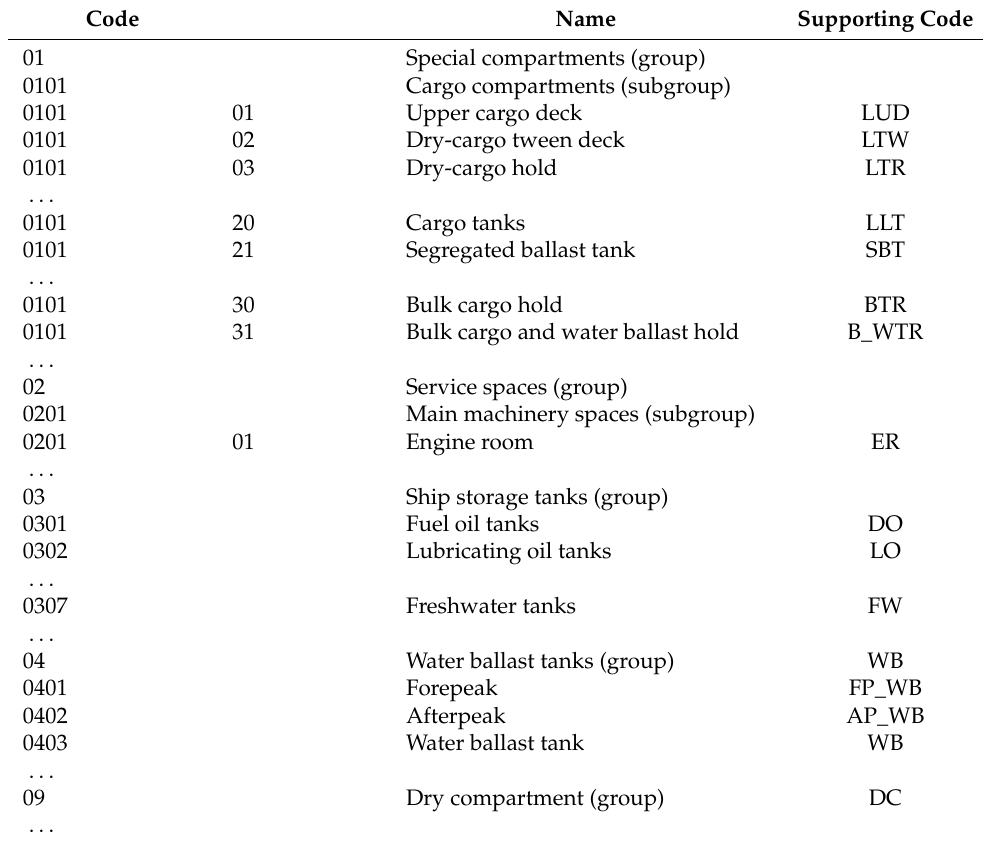
Table 2. Subgroups and groups of ship